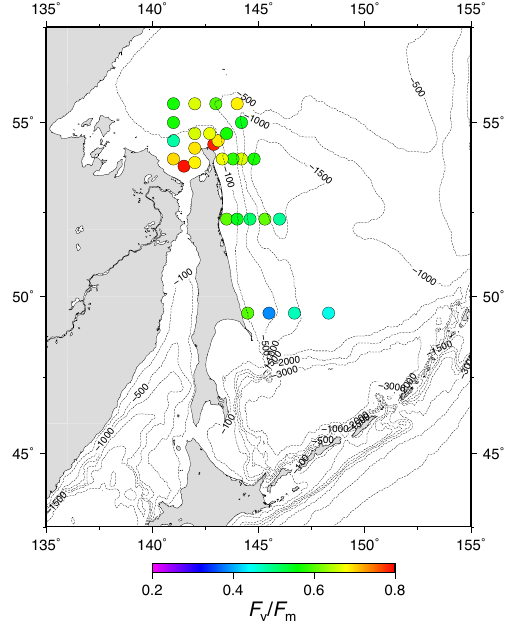
Fig. 11. Plots of F v / F m values for total micro-sized phytoplankton in surface waters at each sampling station.